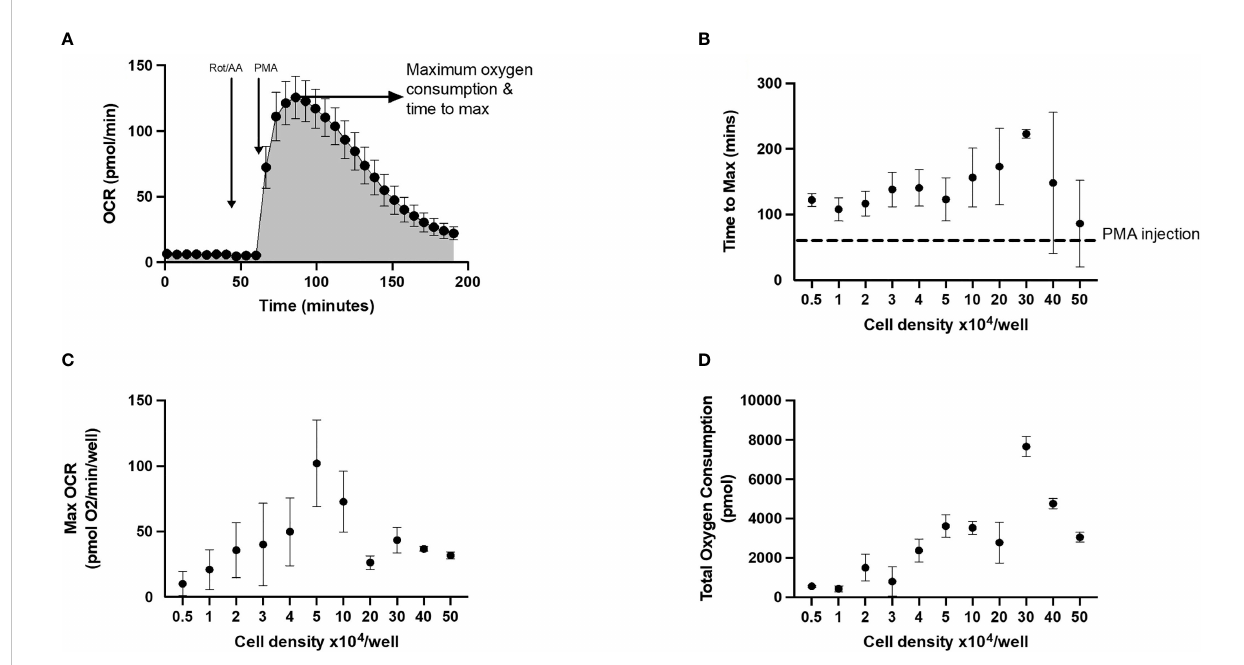
FIGURE 2 Representative trace and optimal cell seeding density to assess neutrophil oxidative burst using XF analysis. Neutrophils seeded at 0.5 – 5 x 10 4 /well in XFe96 cell culture microplates were sequentially injected with 1) XF media (injection 1), 2 µM rotenone/antimycin A (injection 2) and 160 nM phorbol 12-myristate 13-acetate (PMA) (injection 3). (A) is a representative oxygen consumption rate (OCR) trace (n = 1). Area under the curve analysis was performed, to calculate (B) time to maximum OCR, (C) maximum OCR reached and (D) total oxygen consumption over the duration of the test for each cell density (as shown in fi gure 2). Graphs B-D represent the mean ± standard error of the mean (SEM) from 3 distinct